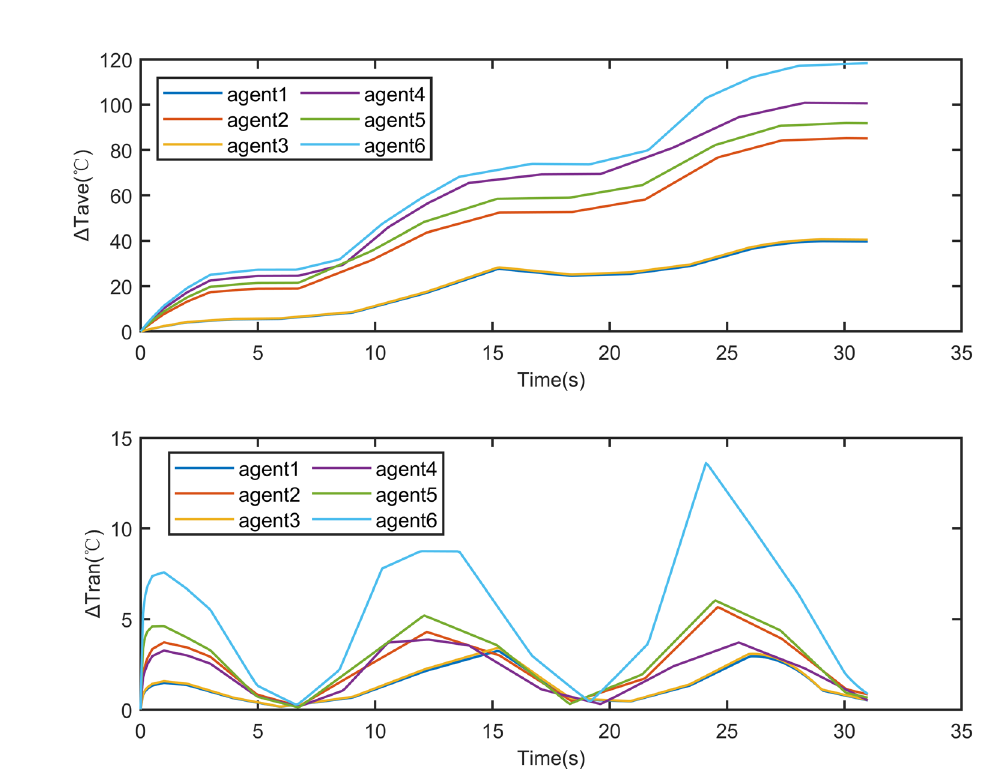
Figure 6: Heating temperature changes at di ff erent positions of the distribution of each microwave source